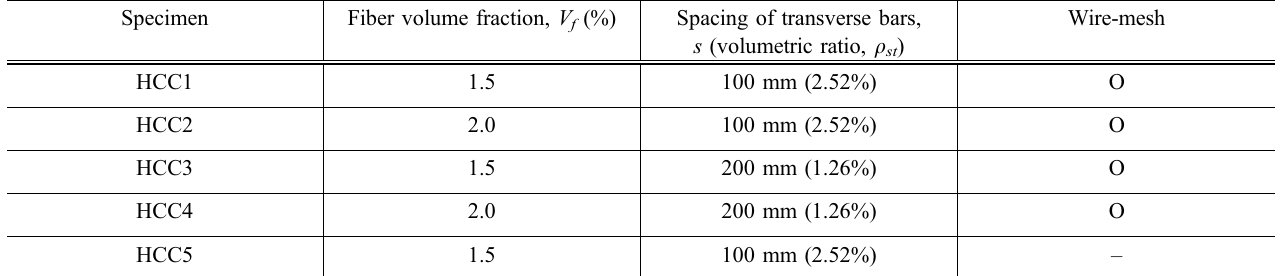
Fig. 2 Details of column specimens (units: mm): a cross-section and b elevation. Table 1 Test parameters of column